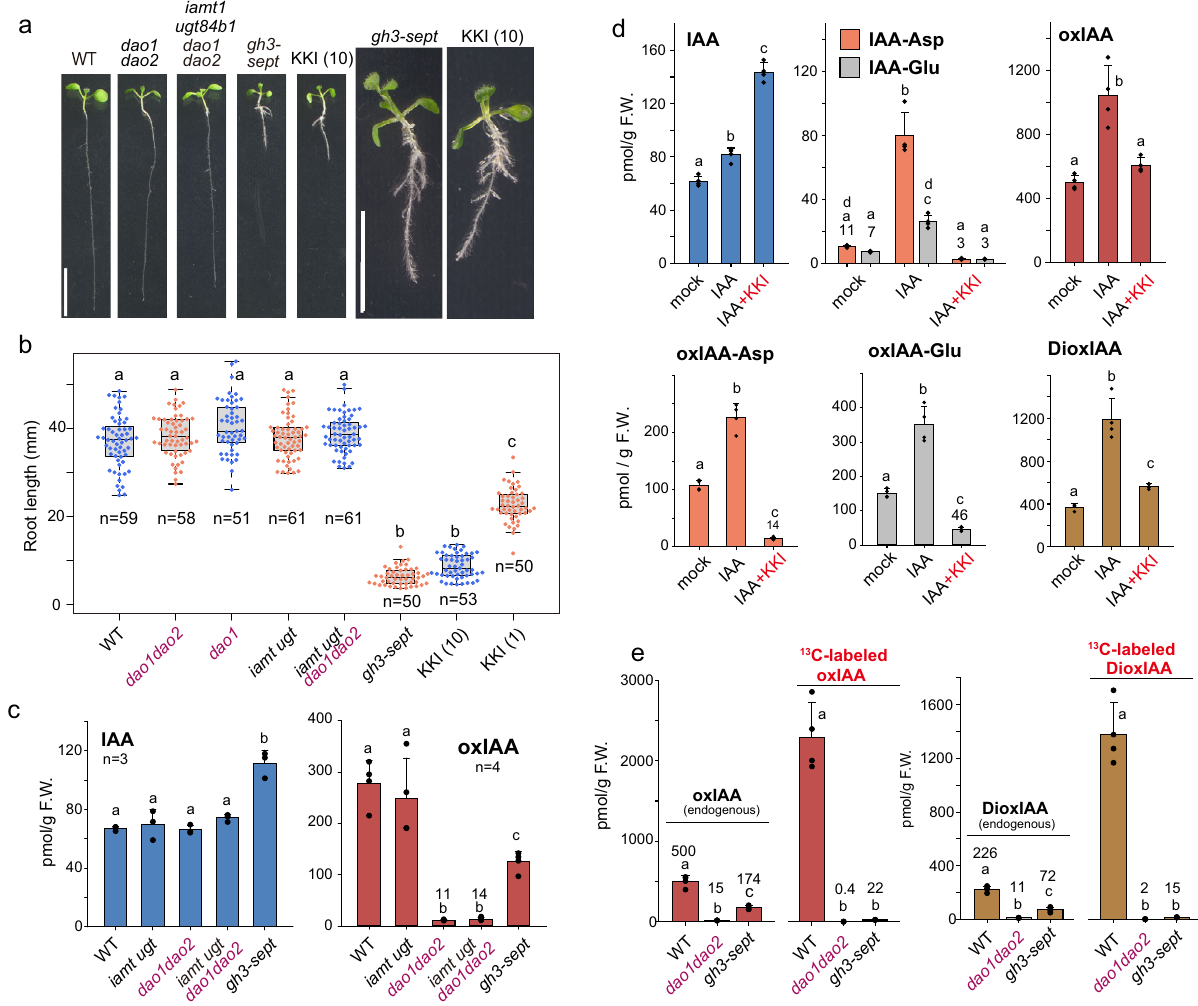
Fig. 2 GH3 plays a central role in IAA inactivation. a , b Phenotypes of the IAA-inactivating enzyme mutants dao1 dao2 , iamt1 ugt84b1 dao1 dao2 , and gh3-1 2 3 4 5 6 17 ( gh3-sept ) as well as WT (Col) plants grown with the GH3 inhibitor kakeimide (KKI) on GM plates for 8 days. Scale bar, 10 mm. The length of 8-d-old root was measured. Box plots show the median as lines in the box, the 1st to 3rd quartiles as bounds of box, whiskers with end caps extending 1.5- fold interquartile range beyond the box, and the end caps represent the minimum and maximum. The different letters represent statistical signi fi cance at P < 0.001 (Tukey ’ s HSD test, n = 50 – 61). The values in parentheses represent μ M. c The levels of endogenous IAA and oxIAA in IAA-inactivating enzyme mutants (8-d-old). d The levels of IAA metabolites after cotreatment with 0.2 μ M IAA and 20 μ M GH3 inhibitor (KKI). WT seedlings (7-d-old) were incubated with IAA and KKI for 20 h. e [ 13 C 6 ]IAA feeding experiment. [ 12 C] - endogenous and [ 13 C 6 ]-labeled oxIAA and dioxIAA were measured using [ 2 H 2 ]oxIAA and [ 2 H 2 ]dioxIAA as internal standards after incubation of 7-d-old WT, dao1dao2 , and gh3-sept seedlings with 0.2 μ M [ 13 C 6 ]IAA for 20 h. c – e The values shown are the means± SD ( d , e, n = 4). The different letters represent statistical signi fi cance at P < 0.01 (Tukey ’ s HSD plants (Fig. 2a, b and Supplementary Fig. 1b). On the other hand, (Supplementary Fig. 2d). On the other hand, the iamt1 ugt84b1 gh3.1 2 3 4 5 6 17 septuple ( gh3-sept ) mutants exhibited very short dao1 dao2 mutants showed the same sensitivity to IAA and KKI roots and more adventitious roots, which are characteristic phe- as the dao1 dao2 mutants, suggesting that IAMT1 and UGT84B1 notypes of auxin overaccumulation 21 . We generated a GH3 do not play major roles in IAA homeostasis in vivo (Supple- inhibitor designated kakeimide (KKI) that competitively inhibited mentary Fig. 2d, e). IAA conjugation (Supplementary methods) 22 . WT seedlings Consistent with the high-auxin phenotypes, endogenous IAA treated with KKI phenocopied gh3-sept mutants which were levels were elevated, and IAA-Asp and IAA-Glu were undetected, insensitive to KKI treatments (Fig. 2a and Supplementary Fig. 2a). in the gh3-sept mutants (Fig. 2c and Supplementary Fig. 3a). KKI caused a signi fi cant accumulation of IAA by inhibiting the conversion of IAA to IAA-Asp and IAA-Glu in WT (Fig. 2d and (Supplementary Fig. 2b) and KKI enhanced the high-auxin Supplementary Fig. 3d). Furthermore, KKI also led to a high phenotypes in the 35 S::YUC1 lines which overproduce auxin accumulation of IAA and repressed the conversion of IAA to (Supplementary Fig. 2c), suggesting that KKI elevated endogen- IAA-Asp and IAA-Glu in YUC2 -overexpressing auxin- ous IAA levels by inhibiting group II GH3 activities. The dao1 overproduction plants (Supplementary Fig. 3d). Endogenous dao2 mutants showed a slightly increased sensitivity to IAA in IAA levels did not differ signi fi cantly between iamt1 ugt84b1 assays of primary root growth compared with that of WT dao1 dao2 mutants and WT plants (Fig. 2c). These results